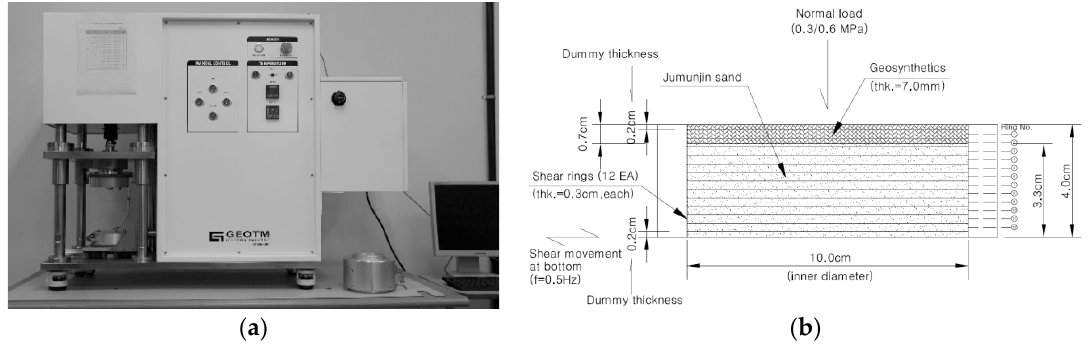
Figure 3. M-PIA: ( a ) photo and ( b ) shear-box details.